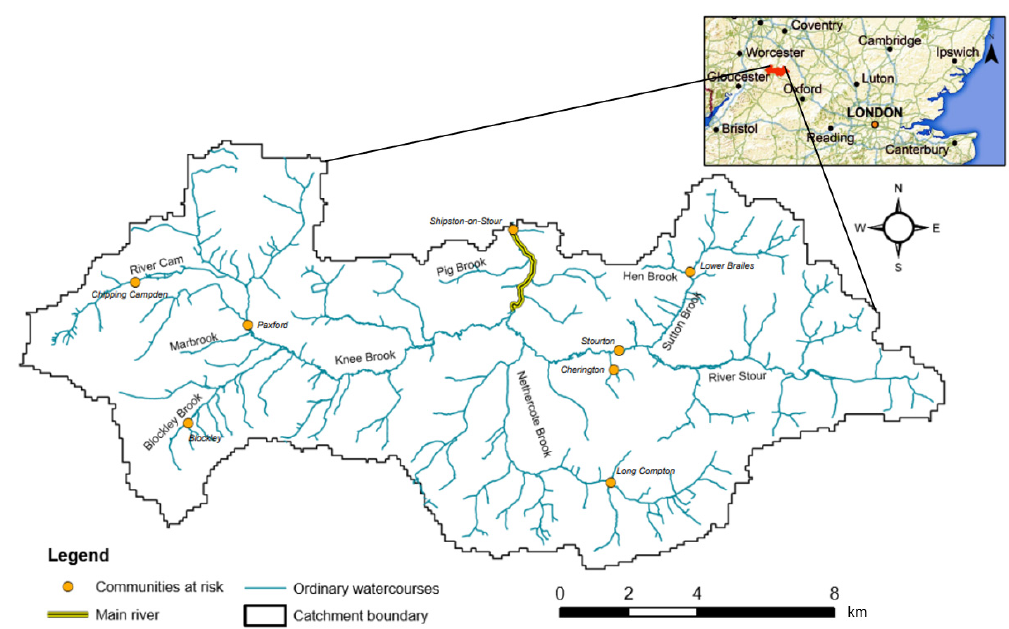
Figure 1. Catchment area (Data Source: [19,20]).